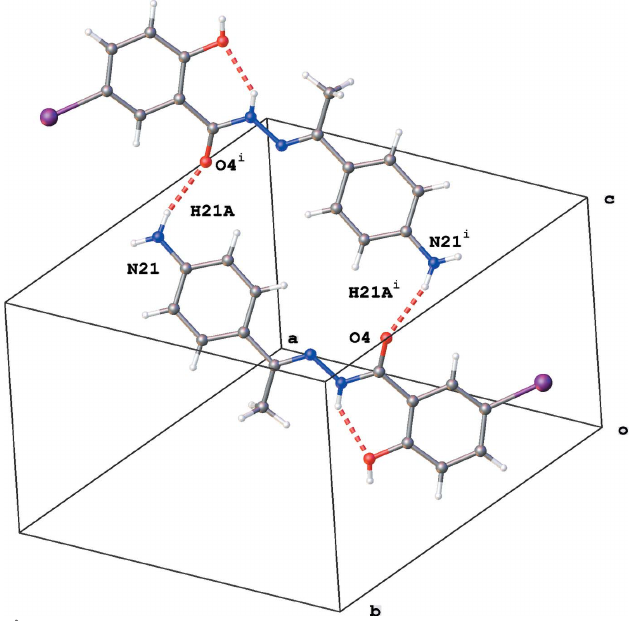
Figure 3 Ring of graph-set motif R 2 (22) formed by N—H (cid:2)(cid:2)(cid:2) O hydrogen-bonding 2 interactions [see Table 1; symmetry code: (i) x (cid:4) 1, y (cid:4) 1, z (cid:4) 2].